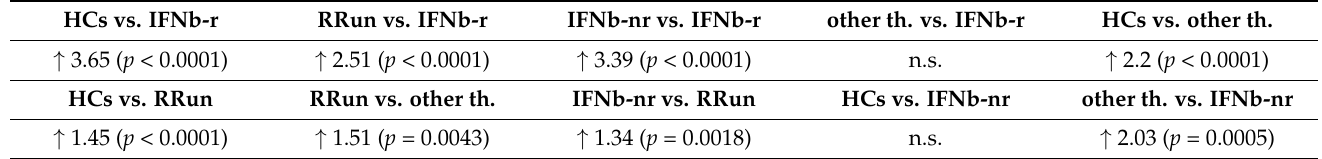
Table 2. Relative ratios values and p values of the compared study groups. HCs, healthy controls; RRun, relapsing remitting untreated MS patients; IFNb-r, responder MS patients to IFNbeta-1a therapies; IFNb-nr, non-responder MS patients to IFNbeta-1a therapies; other th., MS patients treated with other than interferon therapies. Symbol meaning: ↑ = upregulation, n.s. = p > 0.05.